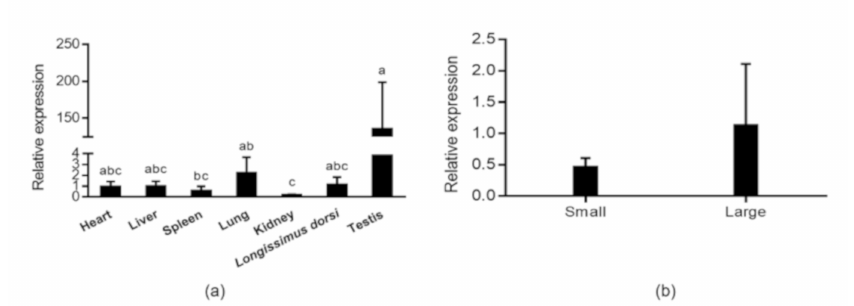
Figure 2. The mRNA expression level of deleted in azoospermia-like (DAZL) in di ff erent tissue and testes with di ff erent size at 6-month old (M6). ( a ): expression level of DAZL in di ff erent tissues at M6; ( b ): mRNA expression level of DAZL in the testes with di ff erent size at M6.